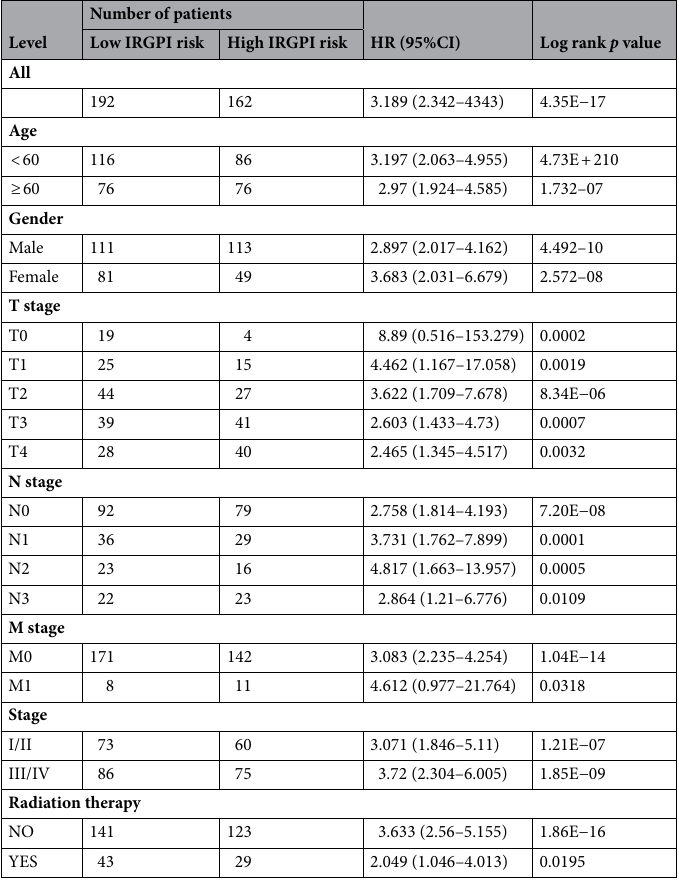
Table 3. The results of clinical subgroup analysis of prognosis based on the IRGPI. Abbreviation: HR hazard ratio, CI confidential interval, IRGPI immune-related gene pairs index.